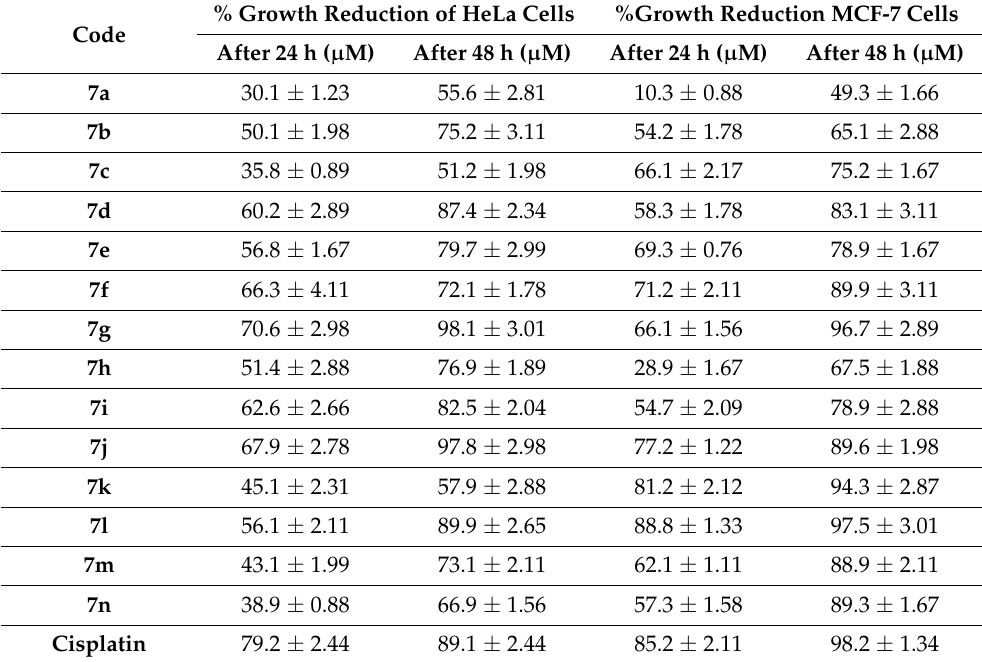
The human cervical cancer cells (HeLa) and MCF-7 cells were treated with 100 µ M concentration for 24 h and 48 h. The concentrations were selected based on the predicted inhibitory values obtained during docking studies (as shown in correlation plot Figure 15).